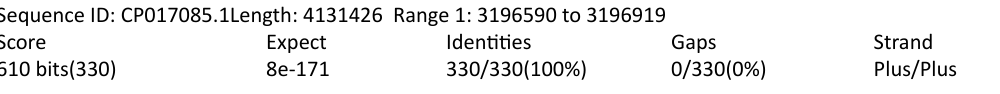
table 4. Alignment of hpmB gene sequence Proteus mirabilis strain T18